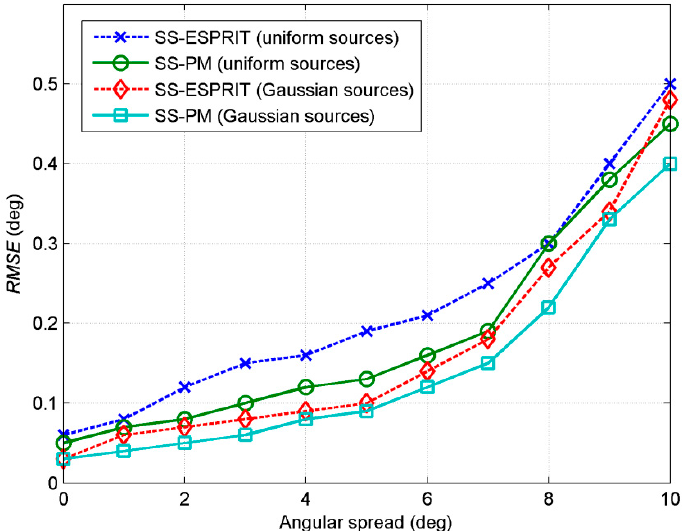
Figure 4. RMSE estimated by the proposed methods versus the angular spread for 2D coherent CD sources.